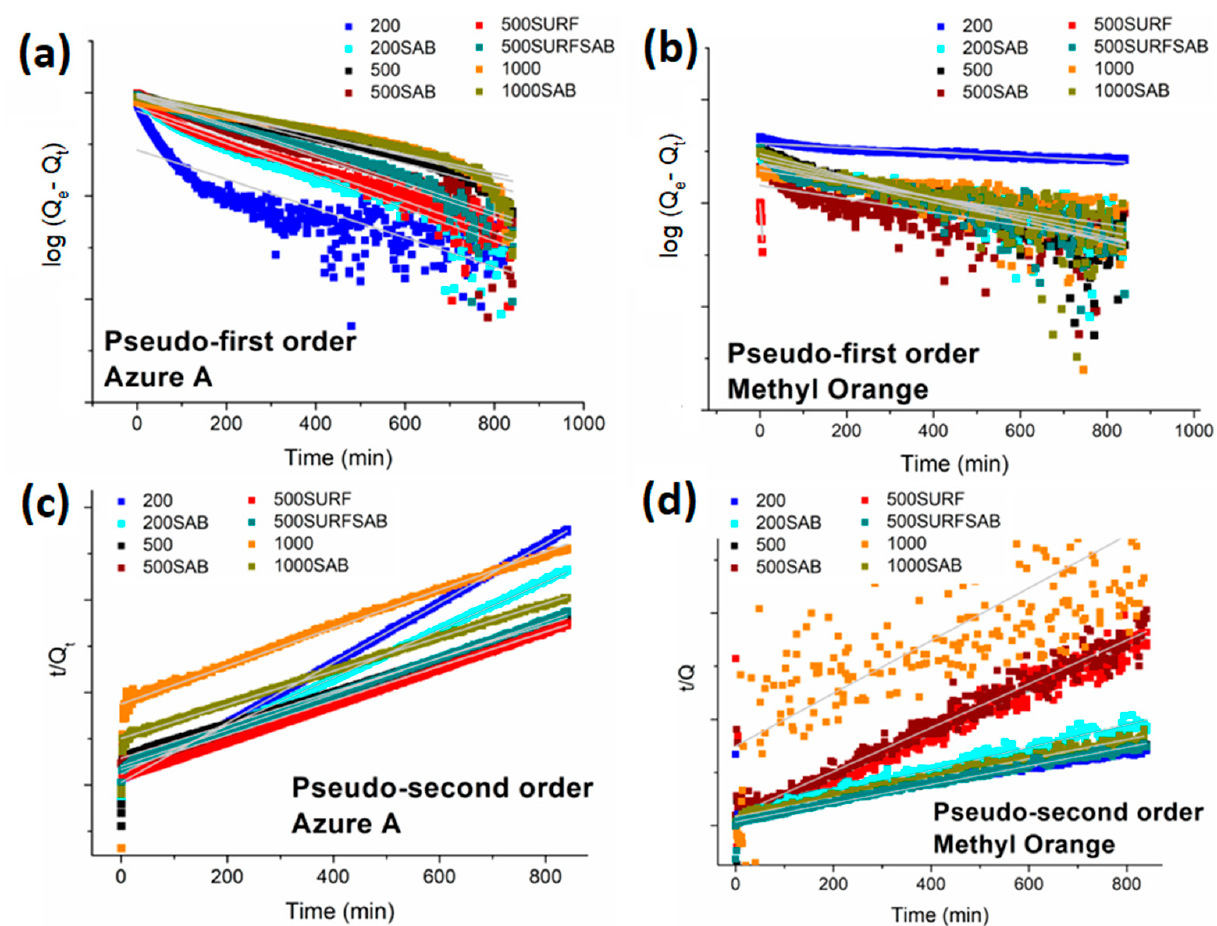
Figure 10. Application of the pseudo-first order adsorption model onto membranes for AZ ( a ) and MO, ( b ) and application of pseudo-second order model onto membranes for AZ ( c ) and MO ( d ). The linearized forms of the pseudo-first (Equation (5)) and the pseudo-second order (Equation (6)) equations are shown below Table 4. Kinetic parameters of the pseudo-first and pseudo-second order models for the adsorption of AZ and MO onto the membranes .